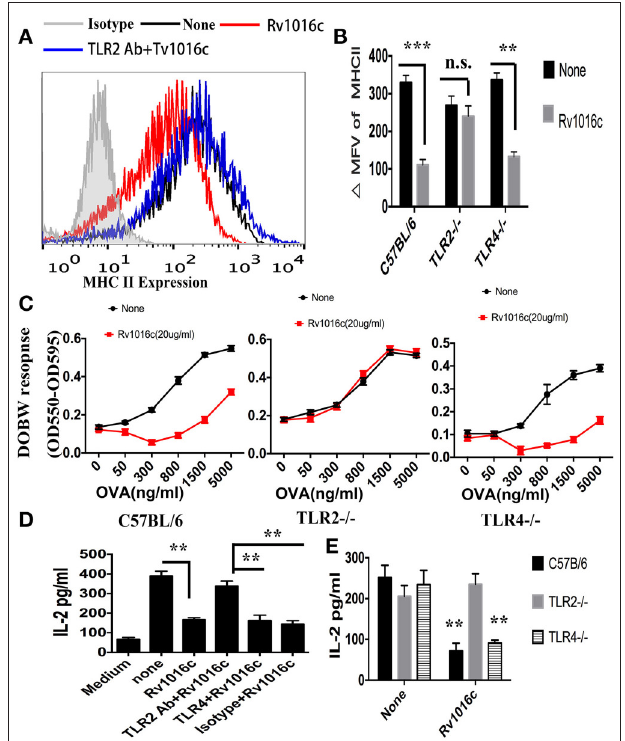
FIGURE 5 | Rv1016c inhibits IFN- γ -induced MHC-II expression and Ag processing. (A) THP-1 cells were stimulated with IFN- γ (15ng/ml) for 24 h at 37 ◦ C, and then treated with or without Rv1016c-His (20 µ g/ml) for 24 (left) or 48 h (right). Cells were incubated with FITC-conjugated anti-MHC II, or isotype Ig G control Abs for 30 min in the dark room. MHC-II expression was analyzed with a BD FACScan flow cytometer. (B) THP-1 cells were incubated with medium, Rv1016c (20 µ g/ml, 50 µ g/ml) or rMPT8 (20 µ g/ml, 50 µ g/ml, as a positive control) in the presence of with IFN- γ (15 ng/ml). MHC II mRNA levels were measured by qPCR. (C) THP-1 (1 × 10 6 cells /well) were incubated with increasing concentrations of Rv1016c or control buffer for 24 h in the presence of IFN- γ (15 ng/ml). Then, cells were washed and incubated with OVA 323 − 339 (800 ng/ml) for 3 h. After fixed in 1% paraformaldehyde and washed extensively, the cells were finally incubated with DOBW T hybridoma cells (1 × 10 6 /well for 24 h). Supernatants from the T hybridoma assay were assessed for IL-2 using a CTLL-2 cell bioassay. (D) THP-1 cells were incubated with 100 µ g/ml Rv1016c in the presence of IFN- γ (15 ng/ml), After 24 h incubation, cells were pulsed with increasing concentrations of OVA 323 − 339 for 3 h. Ag processing was measured with DOBW T hybridoma cells as previously described. (E) HLA-DR1-positive MDMs were treated with increasing concentrations of Rv1016c or control buffer for 24 h. Following incubation with Rv1016c, macrophages were pulsed with OVA 323 − 339 (800 ng/ml) for 3 h. Ag processing was measured with DOBW T hybridoma cells as previously described. (F) HLA-DR1-positive MDMs were incubated with 100 µ g/ml Rv1016c in the presence of IFN- γ (15 ng/ml), After 24 h incubation cells were pulsed with indicated concentration of OVA 323 − 339 for 3 h and fixed. Ag processing was measured with DOBW T hybridoma cells as previously described. Data points represent the mean of triplicate samples with SD and each panel is representative of at least two independent experiments. (* p < 0.05, ** p < 0.01 vs. corresponding controls). derived macrophages (MDMs) were incubated for 24 h with or